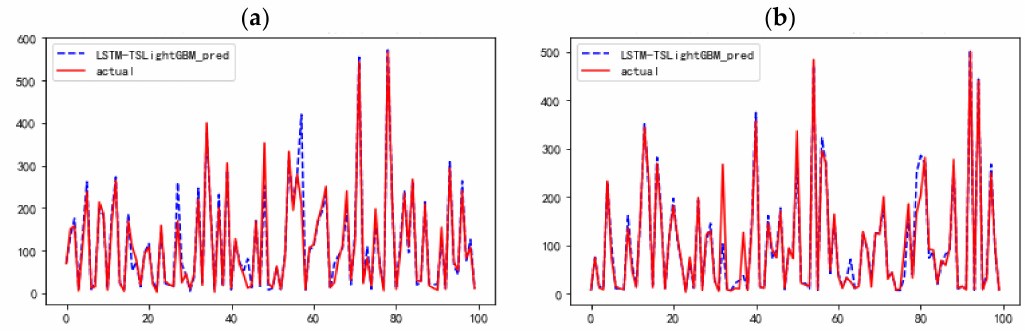
Figure 10. LSTM-TSLightGBM prediction results: ( a ) 100 random samples in the first 50% of the test set, ( b ) 100 random samples in the last 50% of the test set.